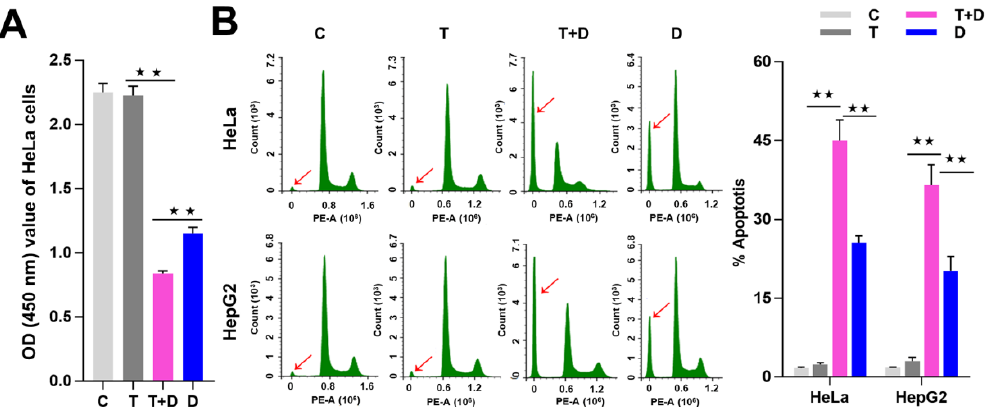
Figure 8. TNF α promotion of apoptosis induced by DOX. (A) Detection of the cell viability by CCK8 assay. (B) Detection of cell apoptosis by flow cytometry (FCM) assay. The sub ‐ G1 peaks of FCM assay